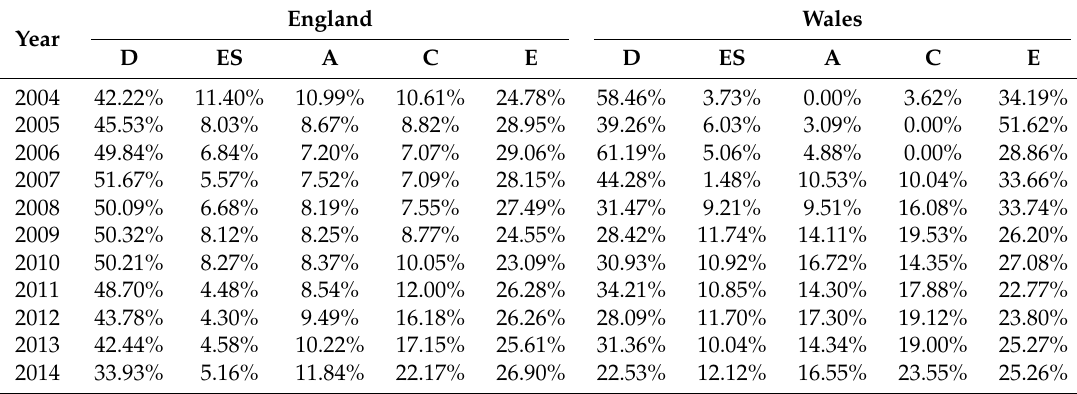
Yearly Averages of the Percentized Hits in Diclofenac, Estradiol, Azithromycin, Clarithromycin, and Erythromycin in England, Wales, Scotland & Northern Ireland,